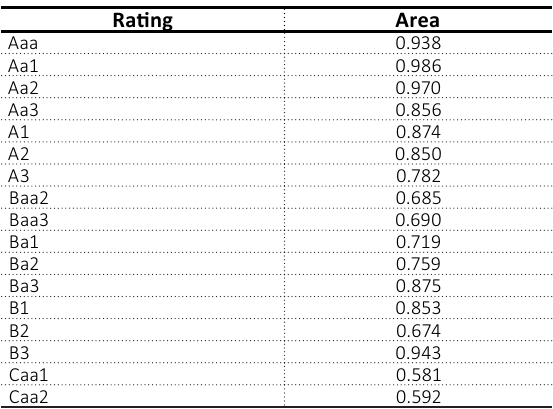
Table 9. Areas under ROC